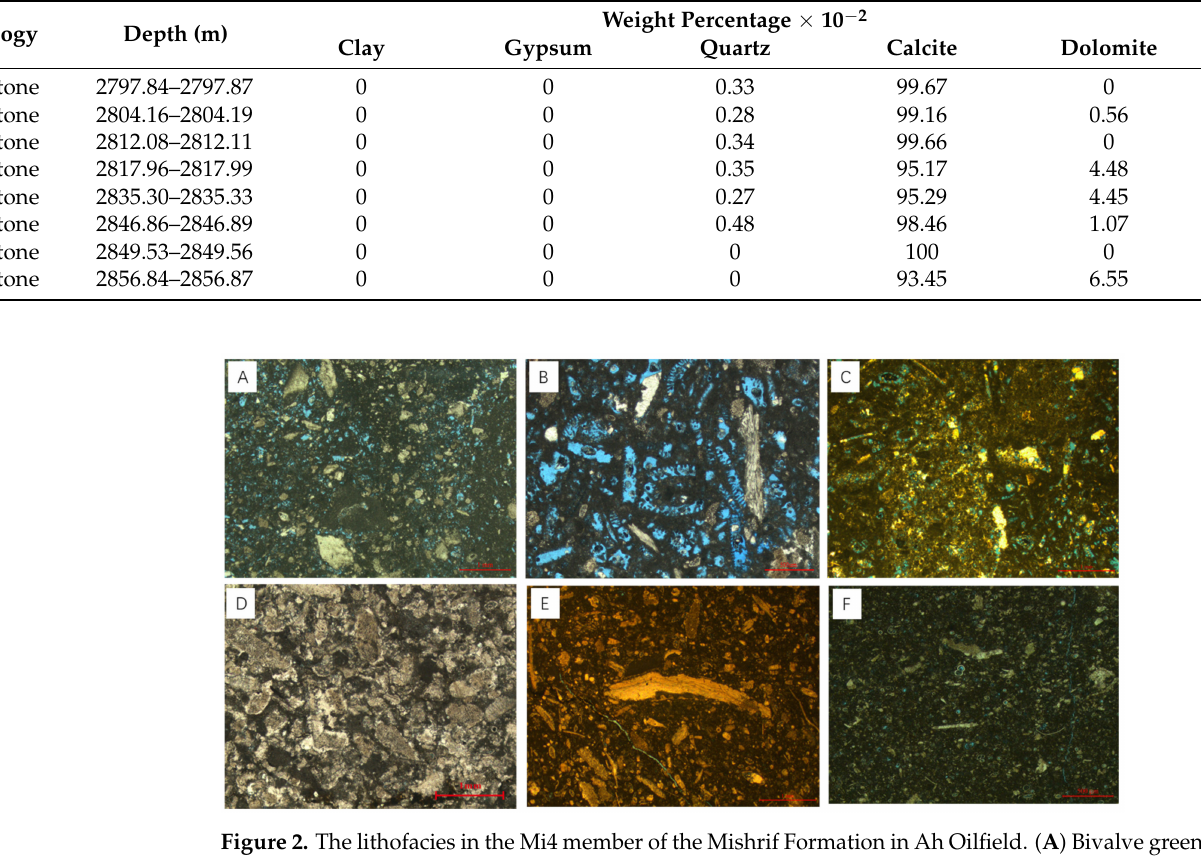
Figure 2. The lithofacies in the Mi4 member of the Mishrif Formation in Ah Oilfield. ( A ) Bivalve green algae packstone; ( B ) green algae packstone; ( C ). pelletoid green algae packstone; ( D ) echinoderm packstone; ( E ) bioclastic wackestone; ( F ) planktonic foraminifera